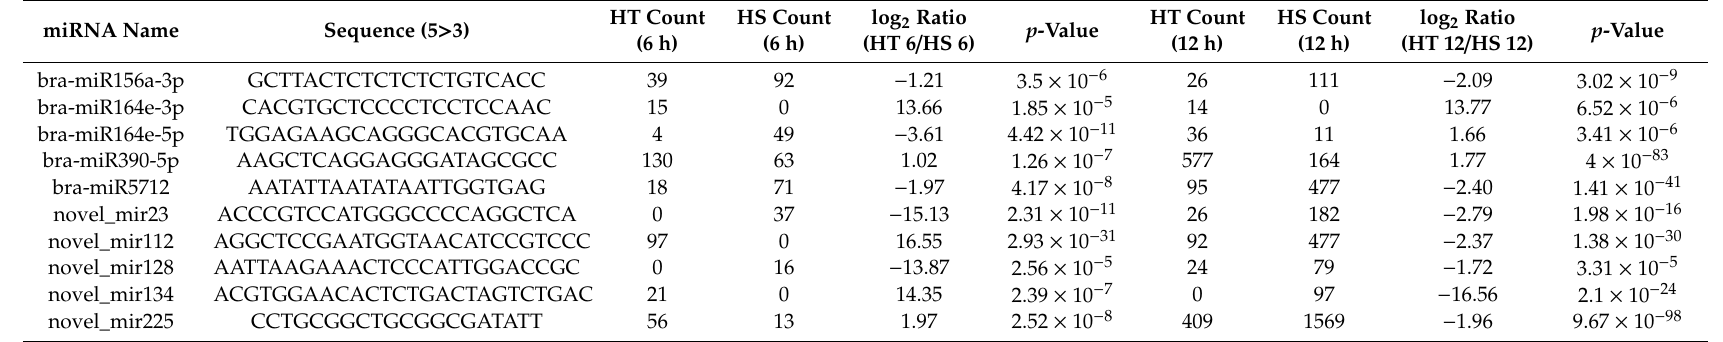
Table 3. Heat-induced di ff erentially expressed known and novel miRNAs identified from both heat tolerant (HT) and heat-susceptible (HS) flowering Chinese cabbage